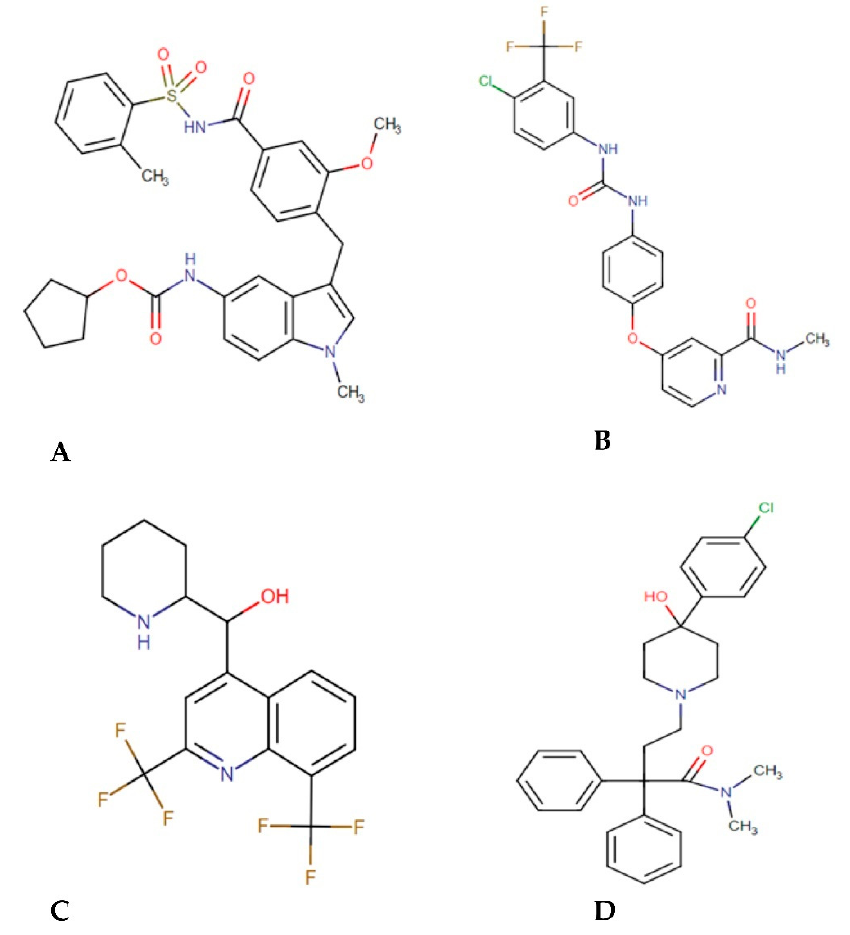
Figure 2. Chemical structures of accolate ( A ), sorafenib ( B ), mefloquine ( C ), and loperamide ( D ).